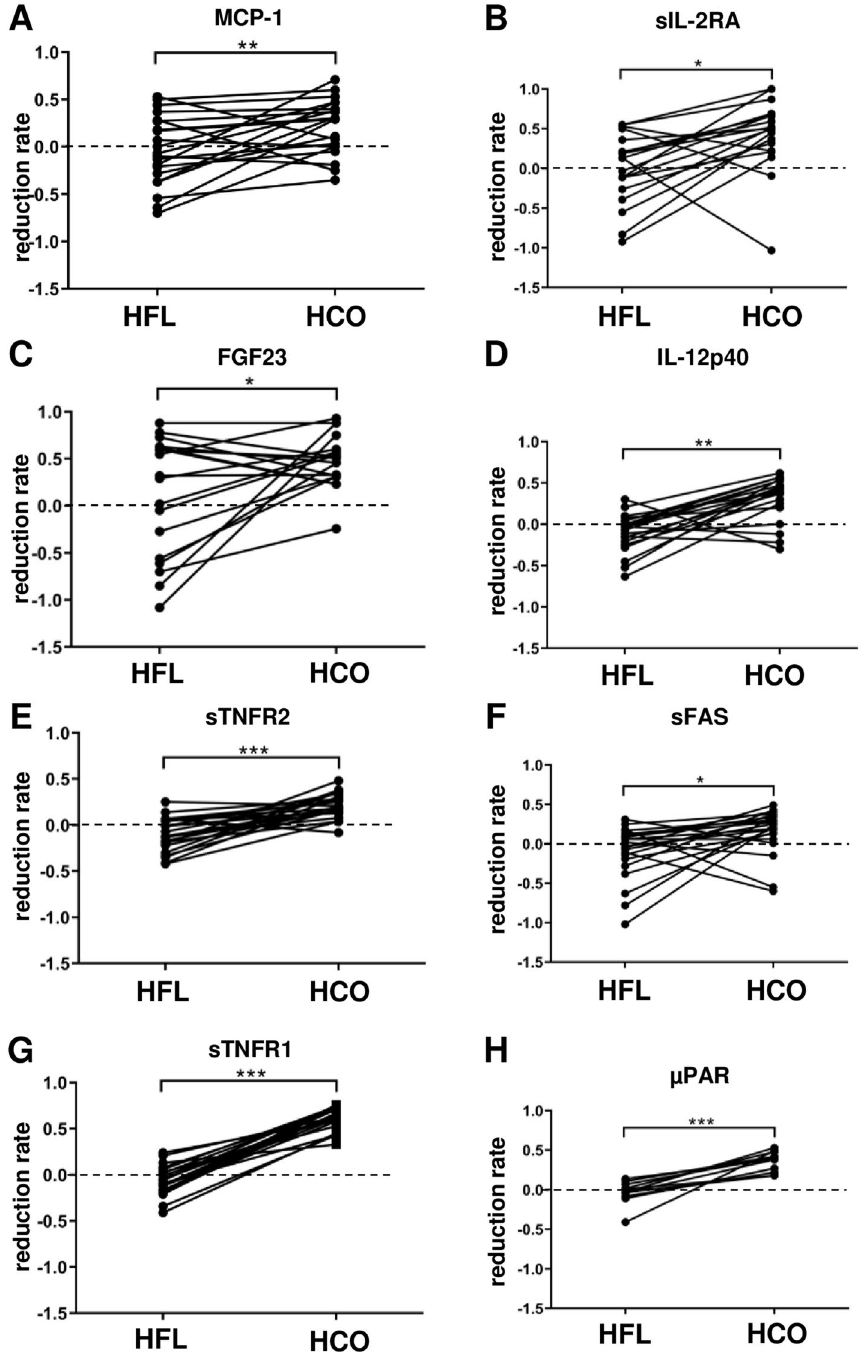
Figure 4. Mediators that were reduced after a single HCO but not HFL dialysis. Blood samples were collected pre- and post-dialysis at the first dialysis session of both experimental phases. Reduction rates were calculated as 1-(concentration post-dialysis/concentration pre-dialysis). ( A ) MCP-1, n = 19; ( B ) sIL-2RA, n = 19; ( C ) FGF23, n = 18; ( D ) IL-12p40, n = 19; ( E ) sTNFR2, n = 19; ( F ) sFAS, n = 19; ( G ) sTNFR1, n = 19; ( H ) µPAR, n = 11. * P < 0.05, ** P < 0.01, *** P <